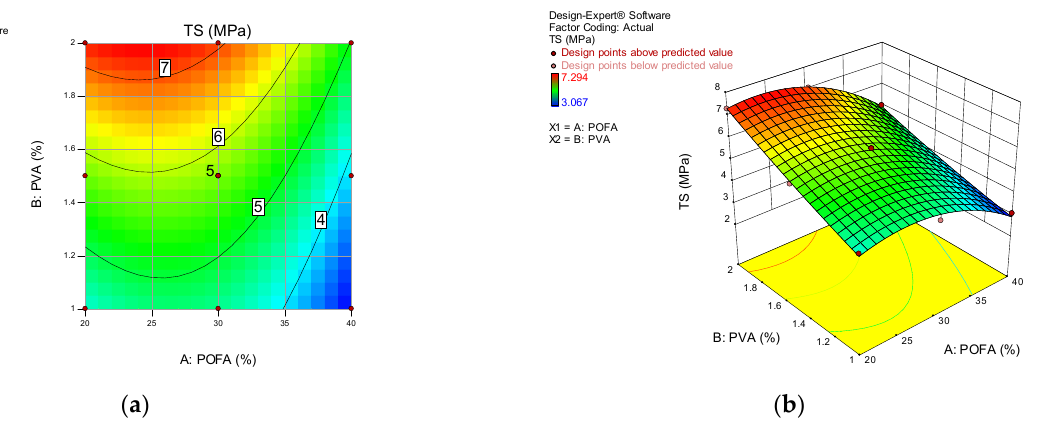
Design-Expert® Software Factor Coding: Actual FS (MPa) Design points above predicted value Design points below predicted value 3.51